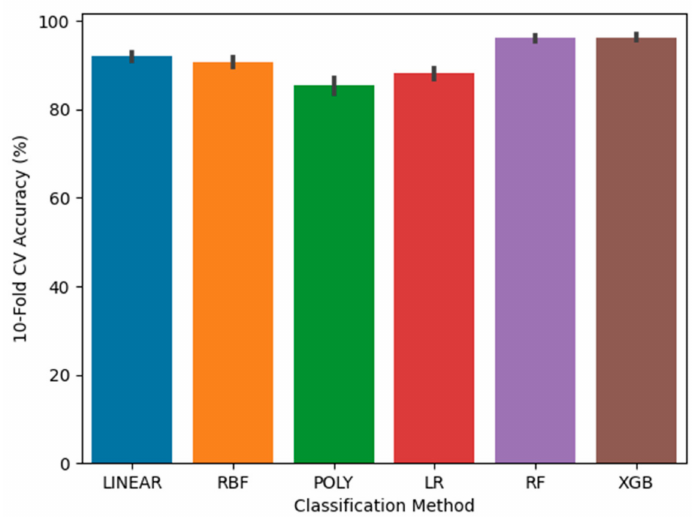
Figure 8. 10-fold CV accuracy for default classification methods (Case